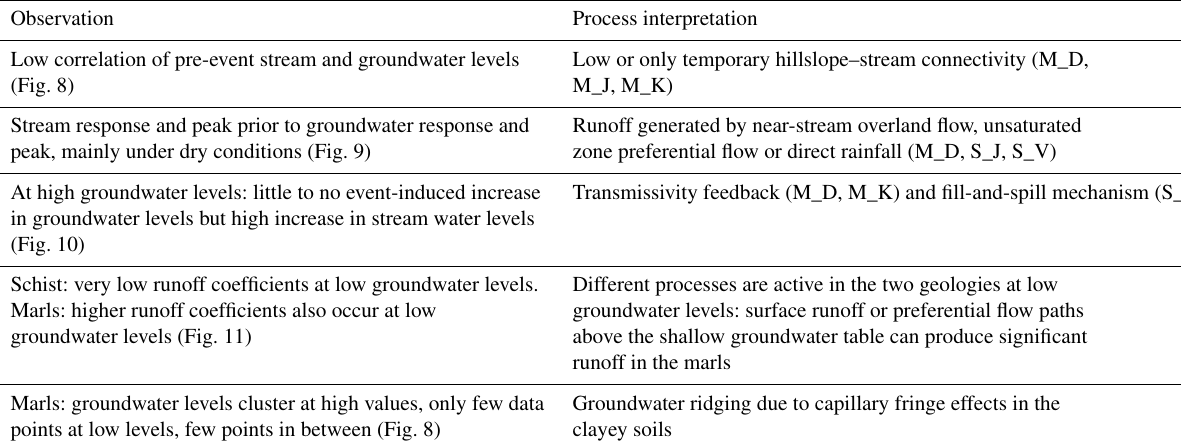
Table 4. Observations and corresponding process interpretations.